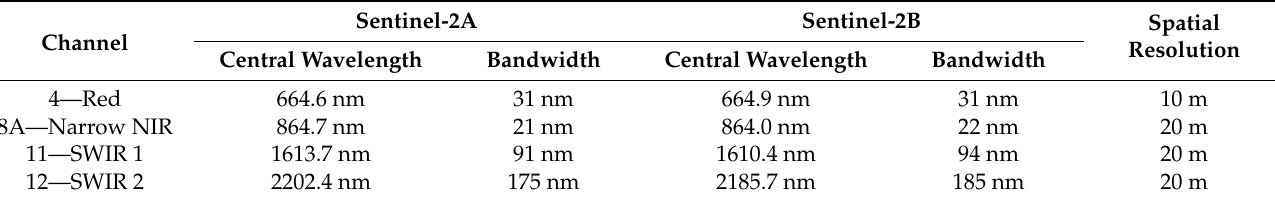
Table 1. List of Sentinel-2/MSI band information used in this